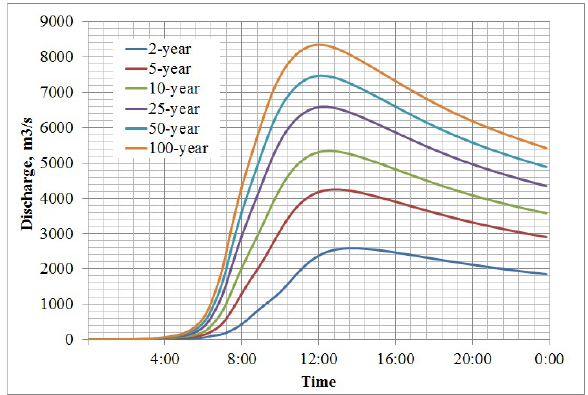
Figure 8: Map showing the validation points in Tago River Basin overlaid in the generated Agaton flood hazard